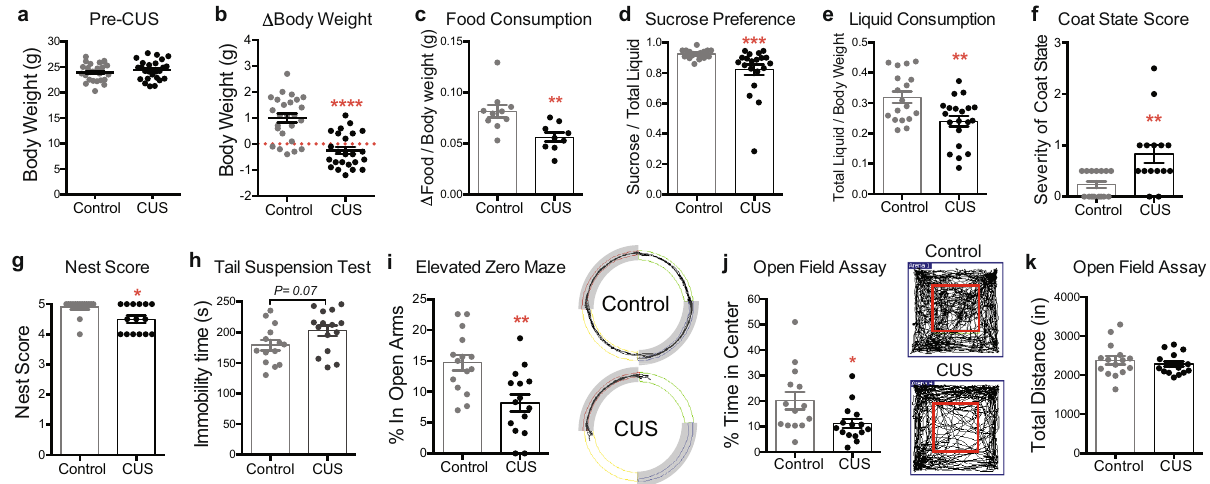
Fig. 1 Twelve days of chronic unpredictable stress (CUS) drives a battery of depressive- and anxiety-like behaviors in adult male mice. a Pre-CUS body weights of 9 – 10 weeks old control and CUS males ( n = 25 per group). b CUS induces weight loss in adult males (Student ’ s t -test; P = 0.0001; n = 25 per group; error bars, s.e.m.). c Food consumption of control and CUS males normalized to body weight (Mann – Whitney U -test; P = 0.0021; n = 10 controls, n = 9 CUS). d CUS decreases sucrose preference in male mice relative to controls (Mann – Whitney U -test; P = 0.0004; n = 18 controls, n = 20 CUS). e Liquid consumption of control and CUS males normalized to body weight (Mann – Whitney U -test; P = 0.004; n = 18 controls, n = 20 CUS). f CUS increases severity of coat scores relative to controls (Mann – Whitney U -test; P = 0.002; n = 15 per group). g CUS decreases nest scores relative to controls (Mann – Whitney U -test; P = 0.01; n = 15 per group). h CUS males show a trend toward enhanced immobility in the tail suspension test (Student ’ s t -test; P